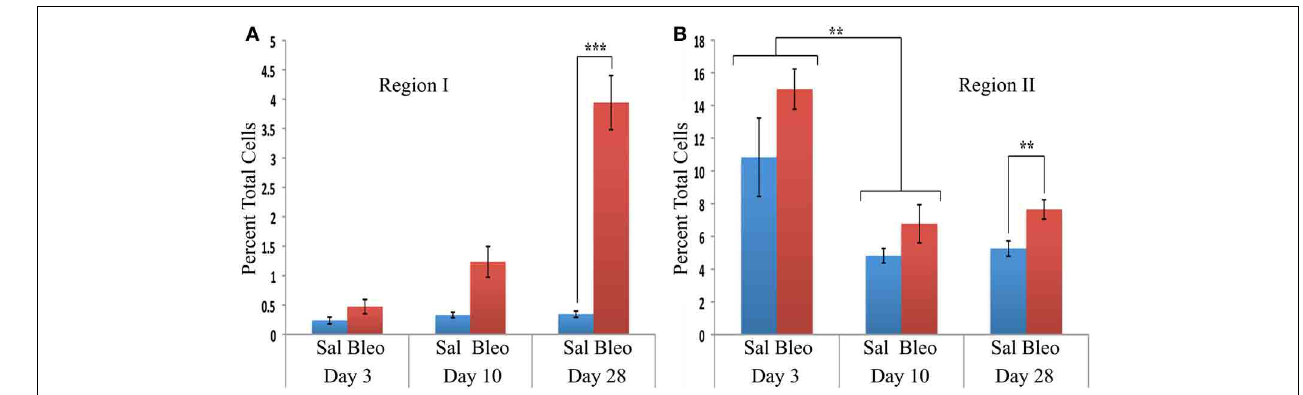
FIGURE 3 | Time course of cell numbers in Regions I and II. The percent of total lung cells in Region I (A) or II (B) in saline- or bleomycin-treated mice 3, 10, or 28 days after initiation of treatment is shown. Sal, saline; Bleo, bleomycin. These data represent the average ± s.e.m. for the following number of mice in each category: 3-day saline, 3; 3-day bleomycin, 3; 10-day